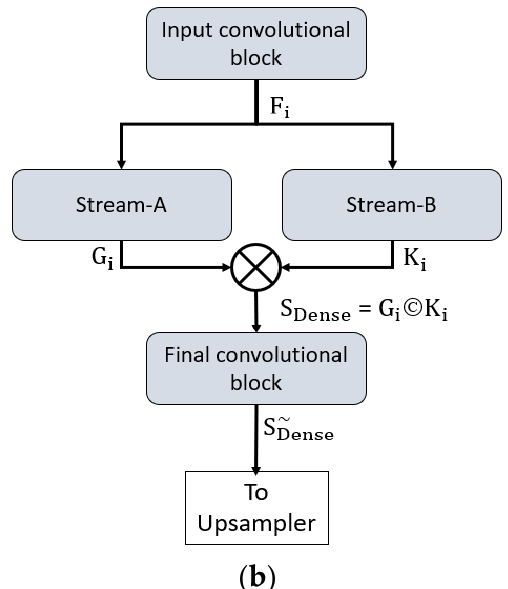
Figure 7. Connectivity pattern for the proposed feature combination: ( a ) Dual-stream feature fusion by element-wise addition in DSF-Net and ( b ) Dual-stream feature aggregation by depth-wise concatenation in DSA-Net.